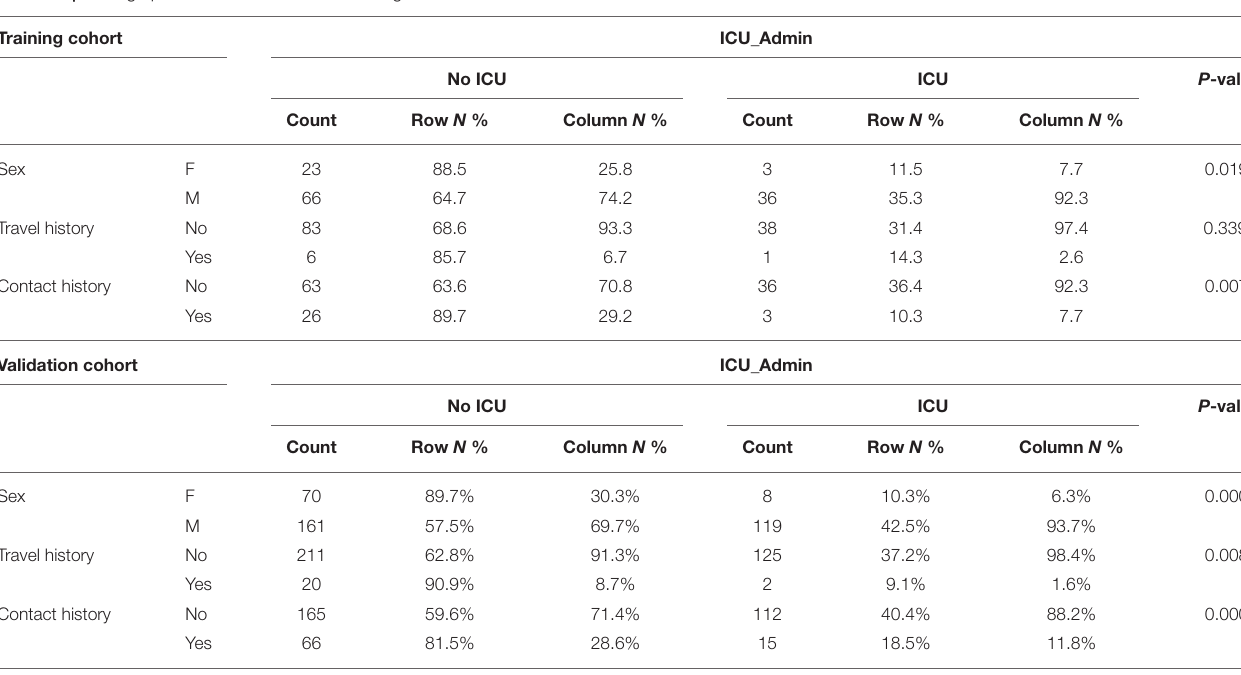
TABLE 1 | Demographic characteristics of the training and validation cohort. Training